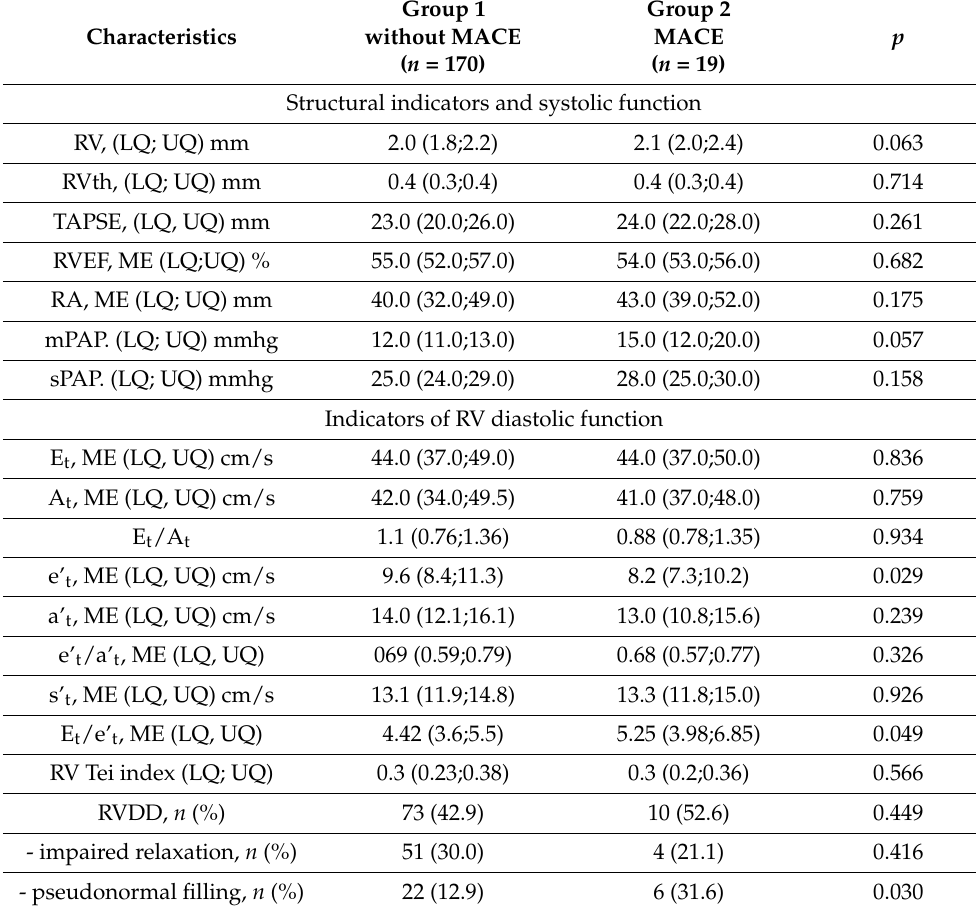
Table 3. Indicators of the right ventricle before surgery in patients with and without MACE 18 months after